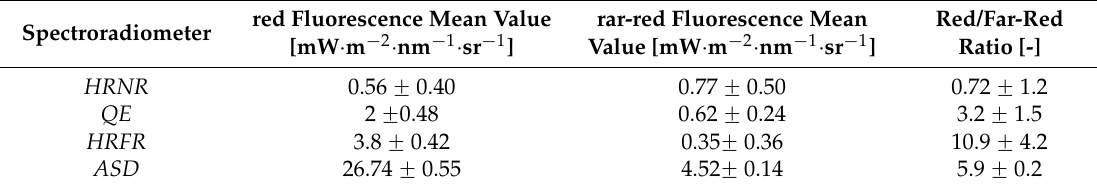
Table 2. The mean values and standard deviations of the red, far-red SIF estimates and red/far-red ratio are reported according to each spectrometer